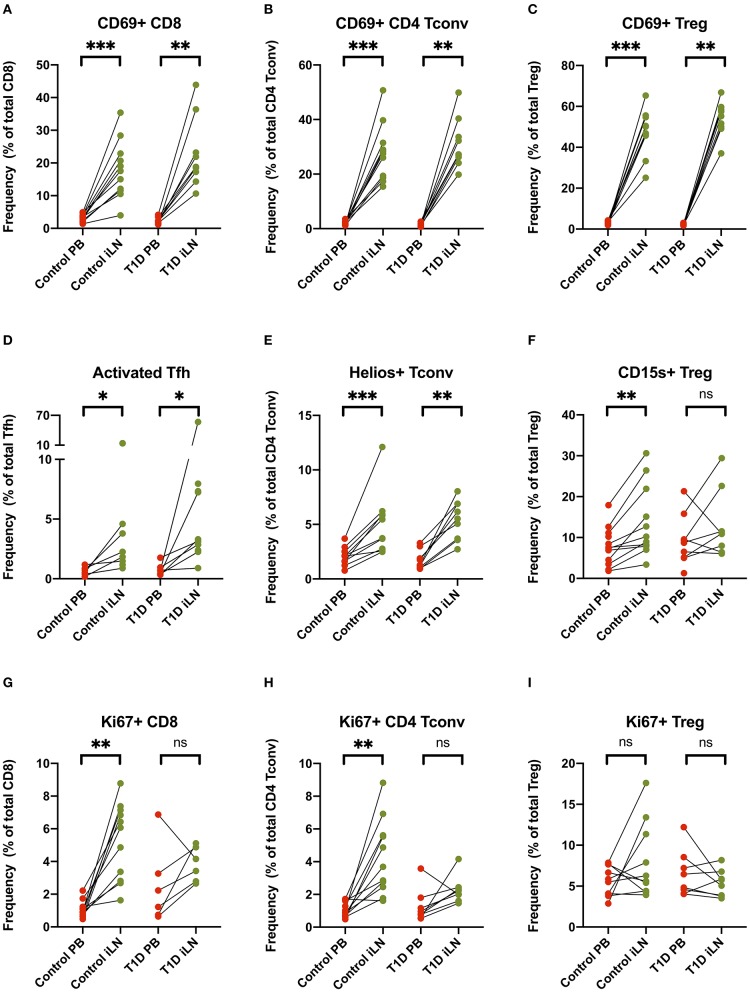
T cell subsets in iLN show enhanced expression of markers associated with activation, proliferation and tissue retention compared to blood. (A–I) Paired frequencies of CD4+ helper T cell populations in blood and iLN from control and T1D subjects. Frequencies of each cell type are expressed as a percentage of total T cell subtype. Student's t-test or Wilcoxon signed-rank test was used. *p < 0.05, **p < 0.01, ***p < 0.001, ns, not significant.